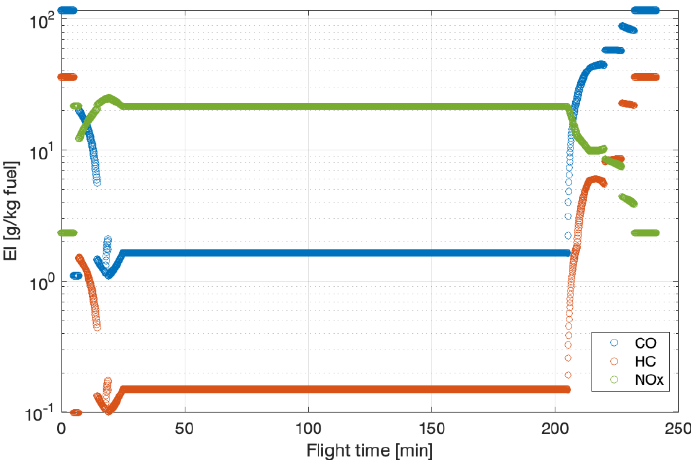
Figure 10. Emission indexes of the Olympus engine evaluated all along the reference Concorde mission with the modified fuel flow method by PoliTO.